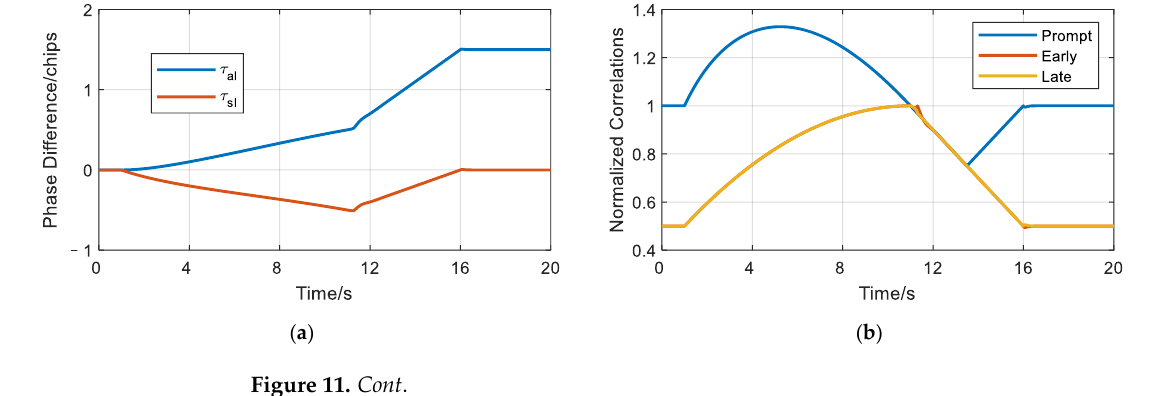
( d ) Figure 11. Theoretical simulation results of strategy 1. ( a ) Code phase differences; ( b ) Outputs of correlators; ( c ) Output of phase discriminator of the code loop; ( d ) Filter output of the code loop.